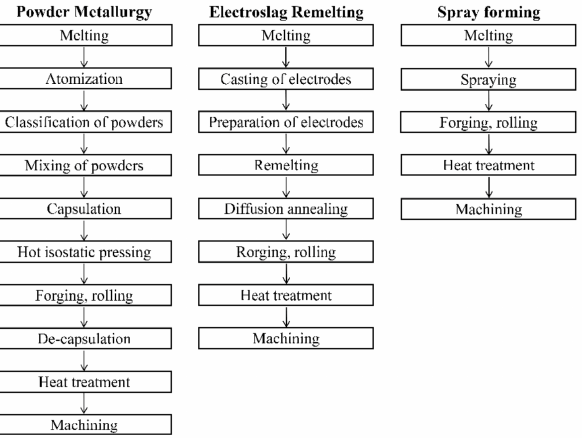
Figure 1. The process steps of powder metallurgy, electroslag remelting, and spray forming